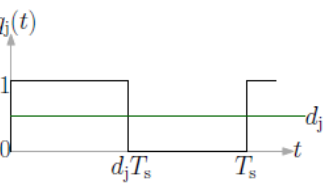
Figure 3. Graphical representation of the switching functions q j (t) as a PWM technique.